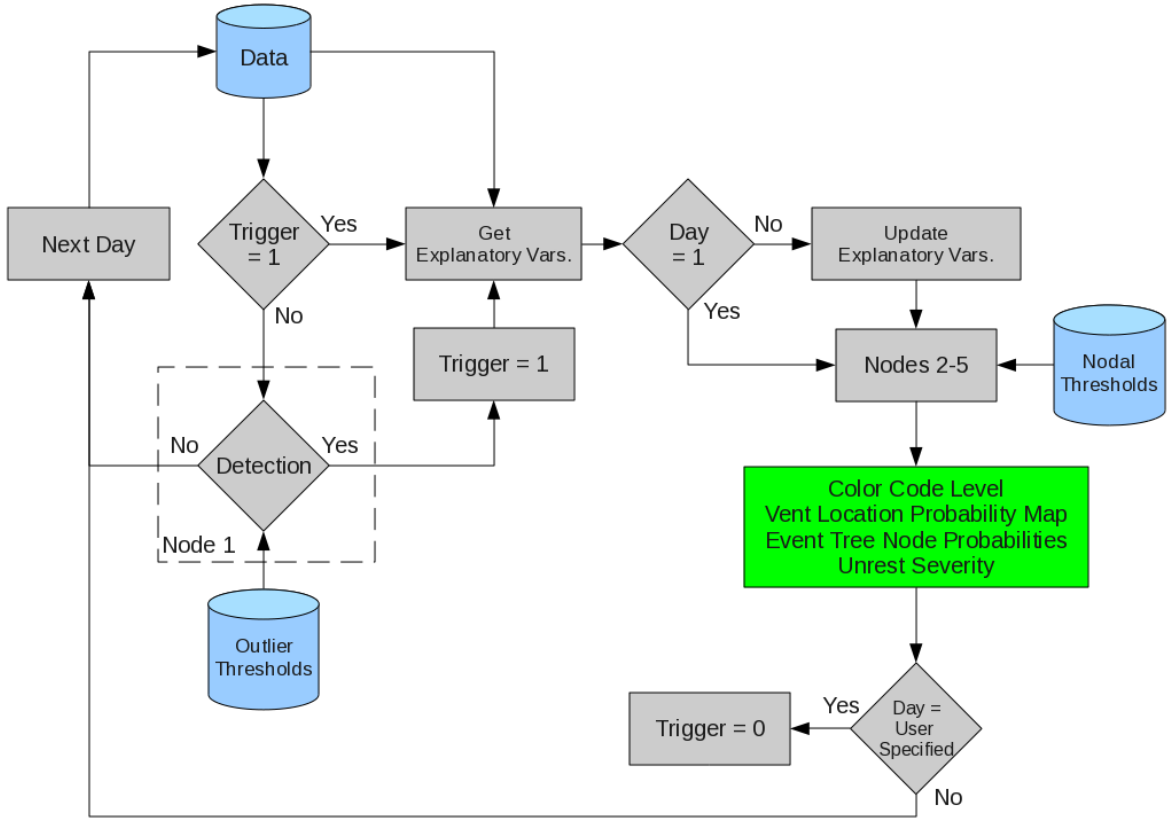
Figure 9. Internal functionality of the forecasting algorithm, where gray indicates processes internal to the algorithm, blue represents external data sources, and green identifies